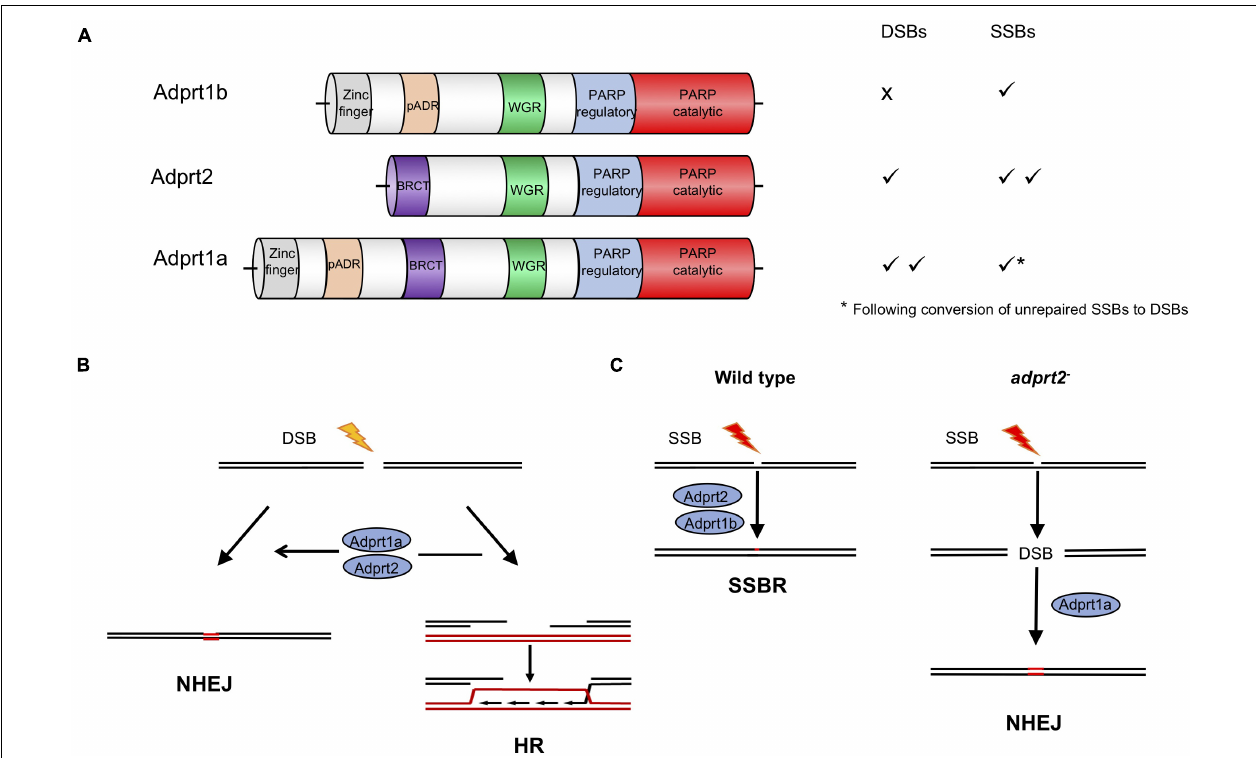
FIGURE 2 | Roles for ADP-ribosyl transferases in strand break repair in D. discoideum cells. (A) Three D. discoideum ARTS have been demonstrated to have a role in DNA repair of strand breaks. As well as a catalytic domain at the C terminus, all three contain N terminal motifs associated with DNA repair proteins in mammals, including BRCT, WGR and zinc finger domains (Otto et al., 2005; Citarelli et al., 2010; Pears et al., 2012). (B) Adprt1a and, in its absence Adprt2, regulate choice between repair of DSBs by NHEJ or HR. Their action favors NHEJ by stabilizing recruitment of the Ku70/80 heterodimer to the ends, protecting them from end resection by nucleases, the initial step in the HR pathway. In D. discoideum Ku70 contains a PBZ domain, an ADPR-binding motif, required to stabilize its association with damaged chromatin (Couto et al., 2011; Hsu et al., 2011). (C) In wild type cells Adprt2 and Adprt1b are required for tolerance to SSBs. In adprt2 − cells, unrepaired SSBs can be converted to DSBs and repair is then dependent on Adprt1a and subsequent Ku70/80 recruitment to promote NHEJ (Couto et al., 2011,